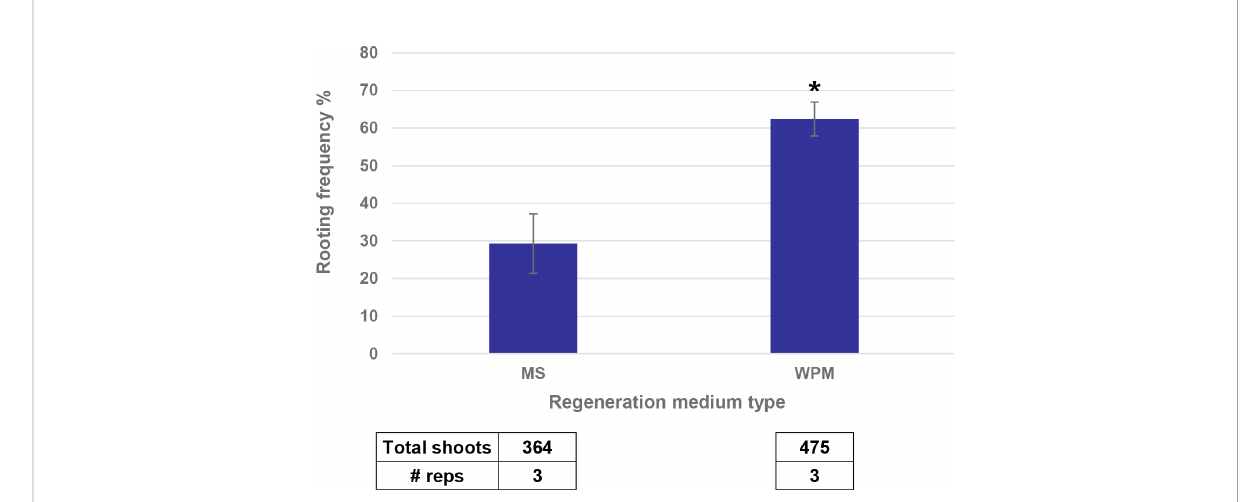
FIGURE 9 WPM medium increased the rooting frequency as compared to MS medium. * indicates signi fi cance at <0.05